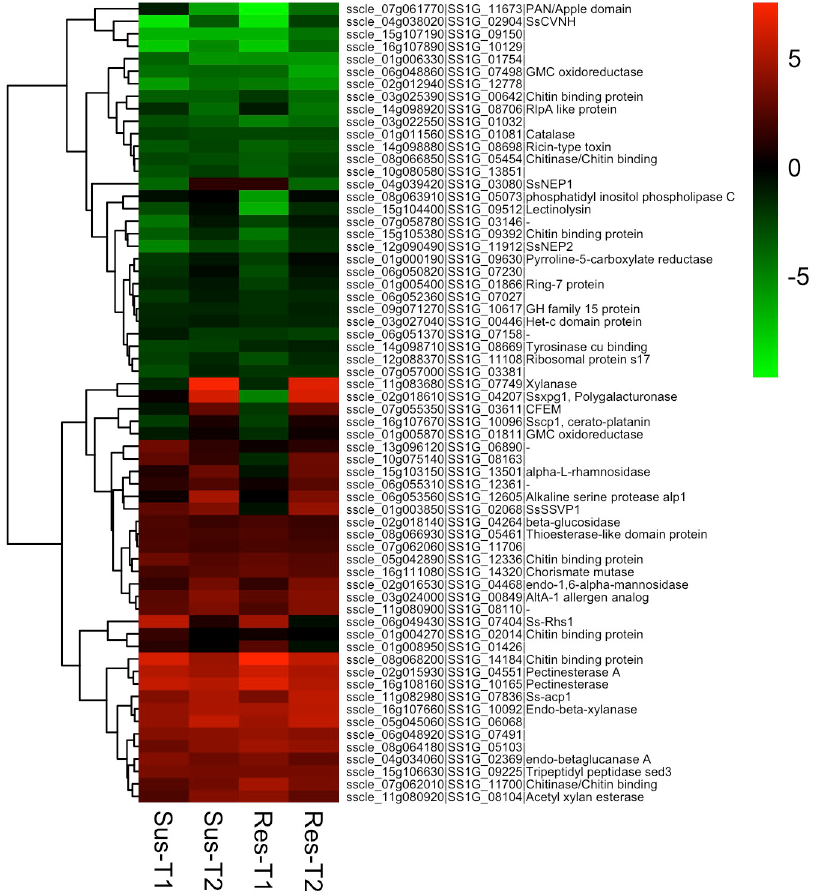
Fig 6. Heat maps showing expression patterns of Sclerotinia sclerotiorum effector genes. Genes are grouped according to hierarchical clustering based on their expression patterns. T1 and T2 represents earlier (8 and 16 hpi) and later (24 and 48 hpi) time points of interaction. The color gradient represents the log2 fold change in gene expression (up-regulation (red), down-regulation (green), and no change (black)) compared to in vitro control.